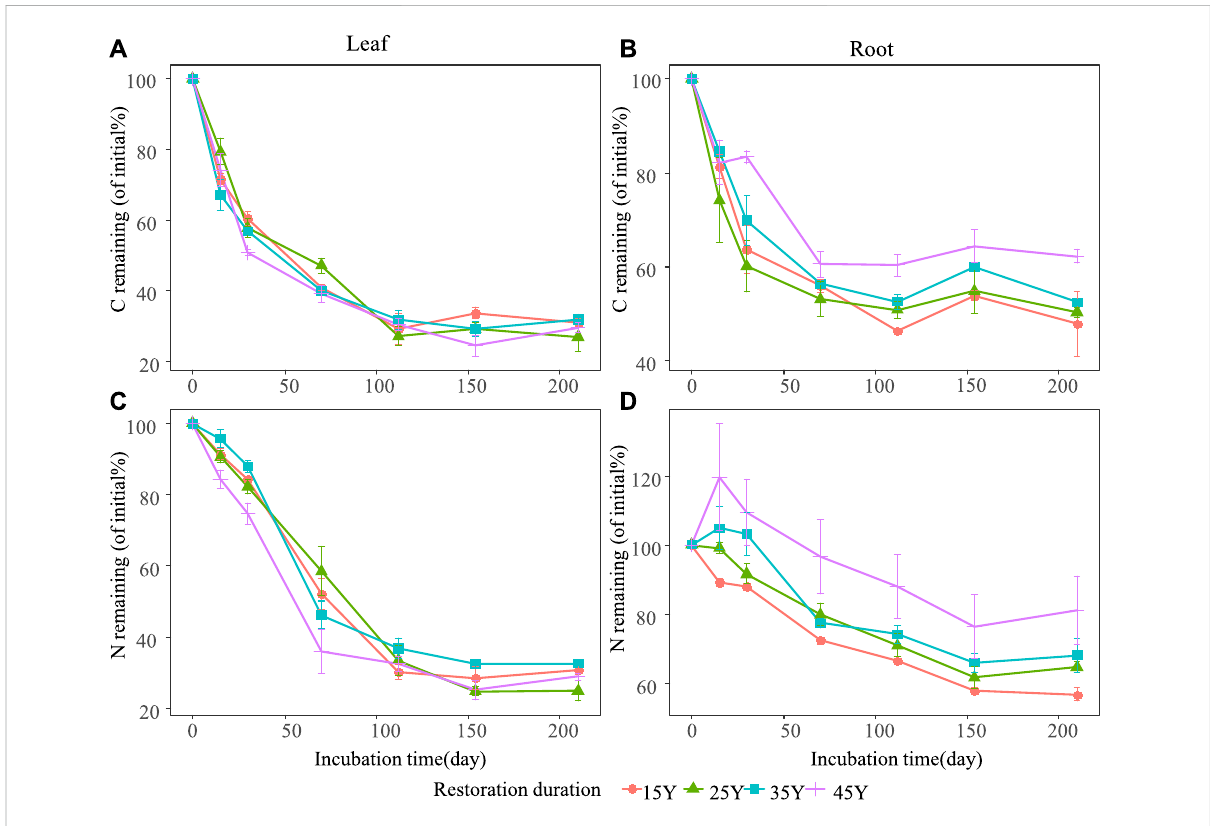
FIGURE 3 Temporal dynamics of litter and root C (A,B) and N (C,D) remaining in four different restoration durations of Robinia pseudoacacia stands. Values are means ± standard